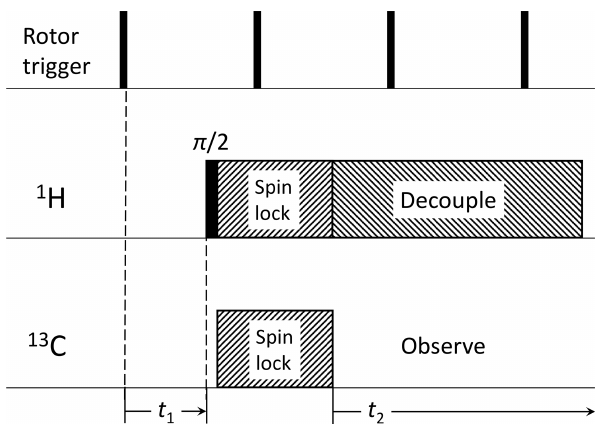
Figure 1. Pulse sequence for 2D syncMAS (Harbison et al., 1987). The direct dimension consists of the usual data acquisition time do- main after cross-polarization, while the indirect dimension consists in an incrementation of the delay between a rotor trigger and the start of the actual pulse sequence, covering a single rotor period T r typically following t 1 = i T r / 2 n with i = 0 ... 2 n (2 n = 16 in our